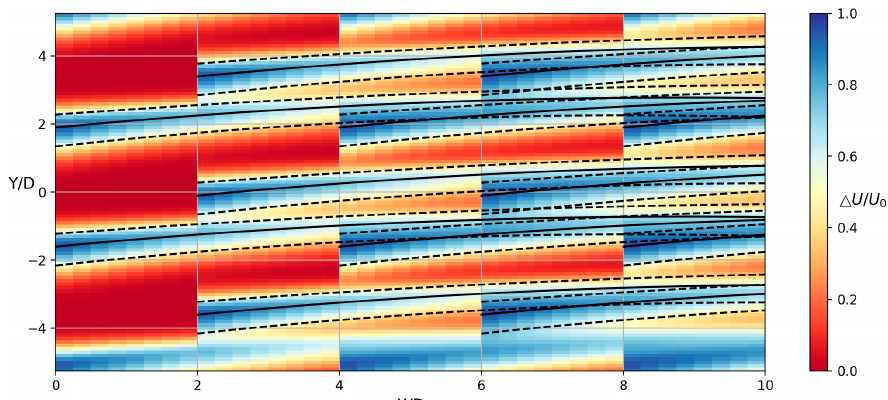
Figure 17. The velocity contour of the array, which is the optimal arrangement under the criterion of array power density (truncation ratio is 0.6). y 1 = 3.5, x 2 = 2, y 2 = 2. The color bar is the velocity deficit, the black solid lines represent the position of the maximum velocity deficit, and the black dashed lines represent the deviations of the double semi Gaussian func- J. Mar. Sci. Eng. 2021 , 9 , x FOR PEER REVIEW